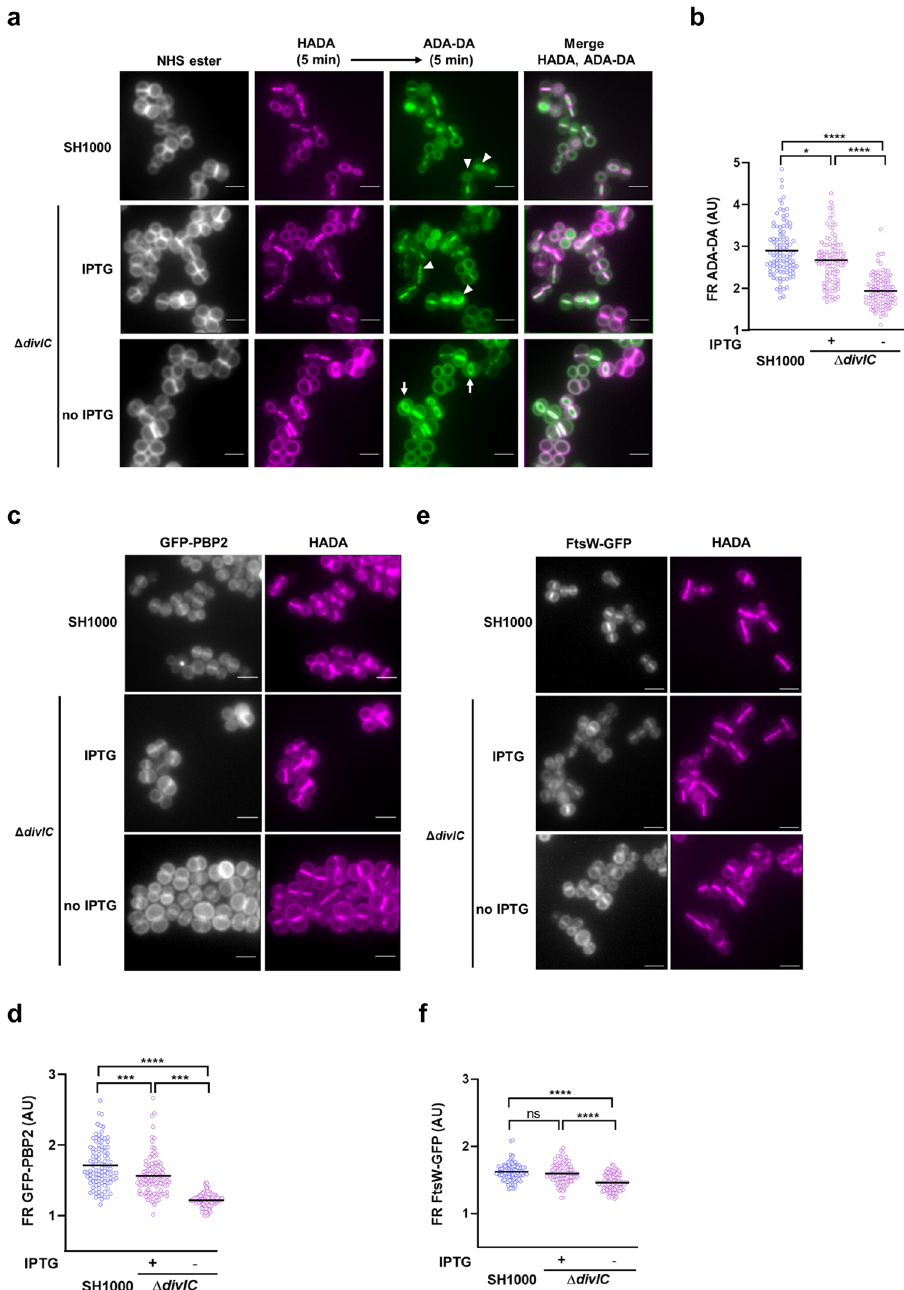
Fig. 4 DivIC spatially regulates PBP-dependent PG synthesis during cell division. a Fluorescence microscopy images of SH1000 and Δ divIC (SJF5450) cells grown for 2h with and without IPTG and subsequently treated with HADA followed by ADA-DA (5min each) to follow PG synthesis. Arrowheads show cells wherePGsynthesisismainlyobservedatthe septum. Arrows showexemplarcells withPGsynthesisatthe septum and cellperiphery. Cells were counter- stained with NHS-ester 555 to image cell walls. b Fluorescence ratios (FR) are the product of fl uorescence signal at the septum divided by the signal at the cell periphery in cells with incomplete septa after incubation with ADA-DA. c Localisation of GFP-PBP2 in SH1000 (SJF5541) and Δ divIC (SJF5560) cells growing with and without IPTG for 2h and incubated with HADA for 30min to label PG. d FR between GFP-PBP2 fl uorescent signal at the septum versus the cell periphery in cells with incomplete septa. e Localisation of FtsW-GFP in SH1000 (SJF5768) and Δ divIC (SJF5767) cells growing with and without IPTG for 2h and incubated with HADA for 30min to label PG. f FR between FtsW-GFP fl uorescent signal at the septum versus the cell periphery in cells with incomplete septa.Each circle indicates a single cell, lines aremean ofan n = 100. P -valuesweredeterminedbyMann – Whitney U- tests(**** P <0.0001; *** P < 0.0002). All images are average intensity projections of z stacks. Scale bars, 2 μ m. Data is representative of two independent The C-terminal domain of DivIC is essential for function, the bacteria, DivIC amino acid conservation is concentrated in the stability and septal localisation . In S. aureus , DivIC has a pre- extracellular domain (Fig. 5a, Supplementary Fig. 6) suggesting dicted topology with a short N-terminal cytoplasmic domain, fol- functional importance. Indeed, a role for DivIC and DivIB in the lowed by a membrane spanning region and an exoplasmic, regulation of peptidoglycan synthesis at the septum has been C-terminal domain of around 74 amino acids (Fig. 5a). Across proposed to rely solely on their external domains in B. subtilis 28 . To